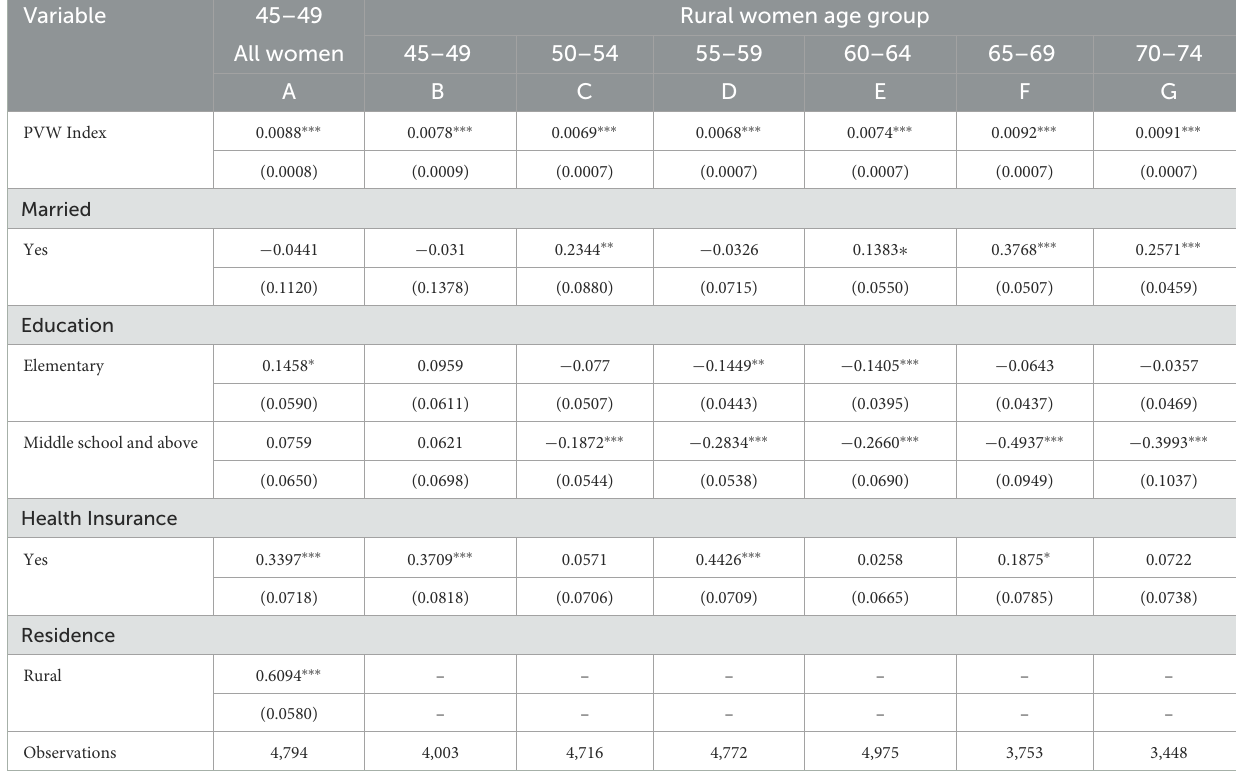
TABLE 3 Benchmark regression of women’s health and labor participation (PVW